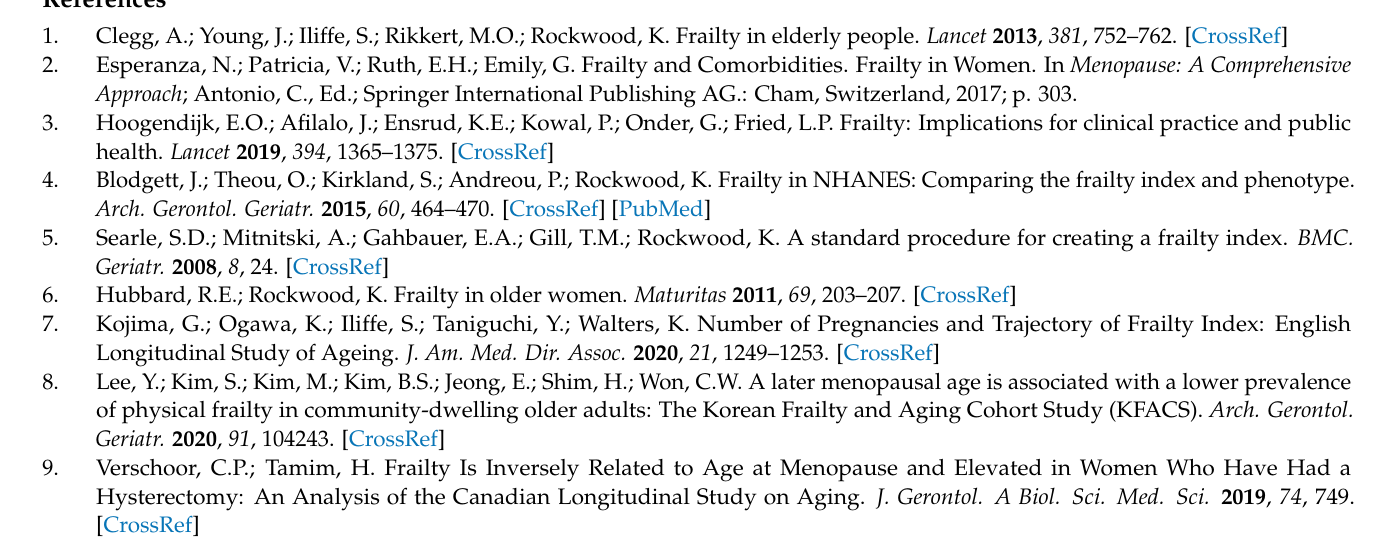
Table S2. Balance diagnostics of variables included in propensity score model. Table S3. Comparison of number of comorbidities, stratified by age at baseline. Table S4. Comparison of characteristics between treatment groups before and after IPTW. Table S5. Characteristics associated with frailty (IPTW regression analysis, Model 3). Table S6. Characteristics of the subgroups in